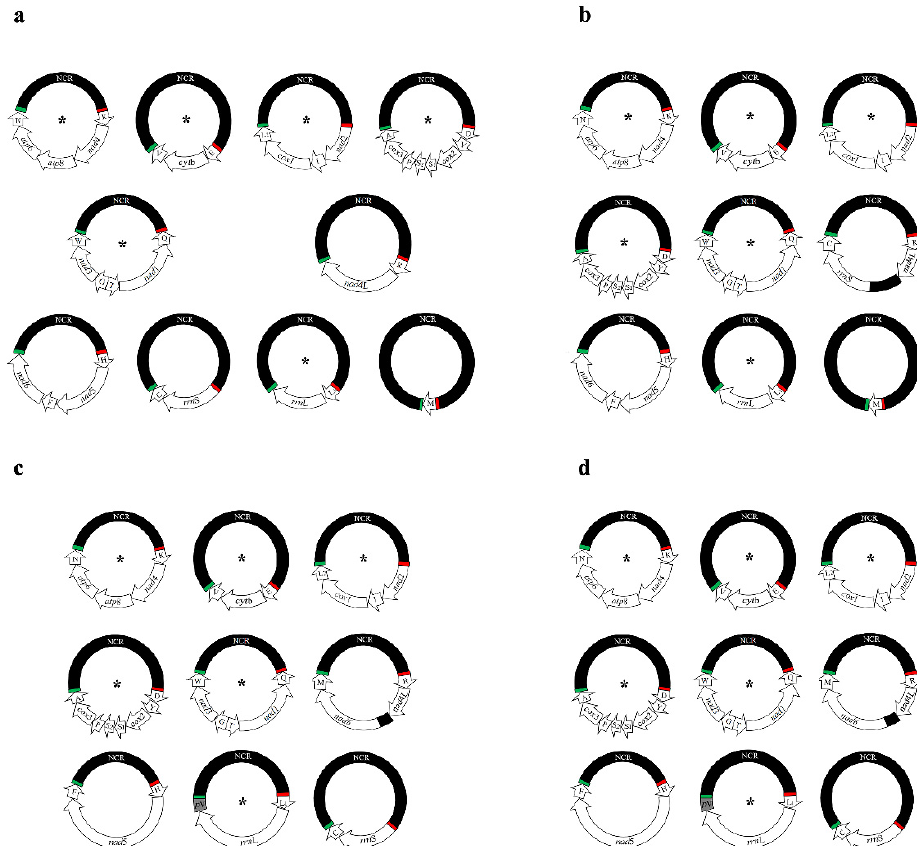
Figure 3. The differences among all minichromosomes of four Haematopinus lice. ( a ) Ten circular minichromosomes of Haematopinus tuberculatus ; ( b ) Nine circular minichromosomes of H. asini ; ( c ) nine circular minichromosomes of H. suis . ( d ) Nine circular minichromosomes of H. apri . See Figure 1 legend for gene name abbreviation, p V indicates pseudo trn V. * indicates the identical minichro- mosomes identified among four Haematopinus lice.